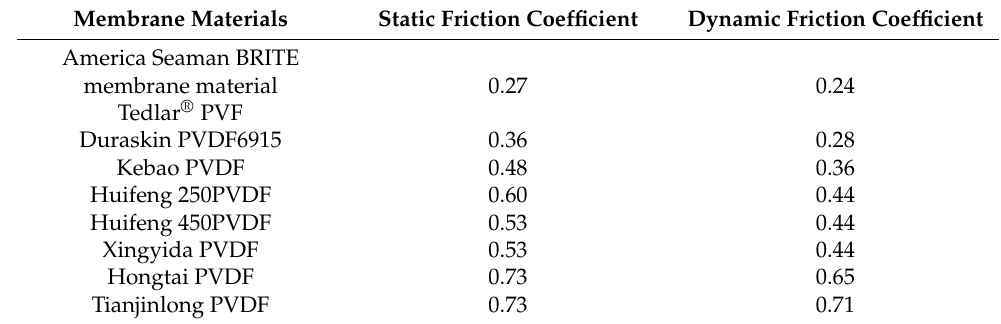
Table 1. Friction coefficient of different membrane materials.